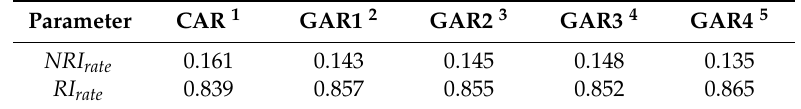
Table 5. Non-renewable inputs (NRI) and renewable inputs (RI) rates for the five artificial reefs analysed in this